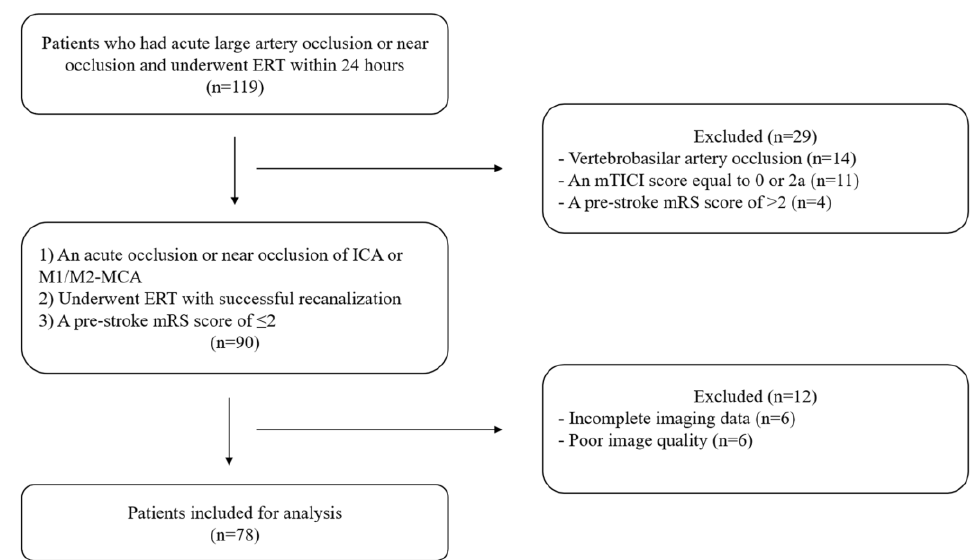
Figure 1. Flow chart. ERT: endovascular reperfusion therapy, mTICI: modified thrombolysis in cerebral ischemia, mRS: modified Rankin Scale, ICA: internal carotid artery, MCA: middle cerebral artery. Table 1. Clinical and imaging characteristics of the study cohort classified by the outflow of transverse sinus and internal jugular vein on the affected